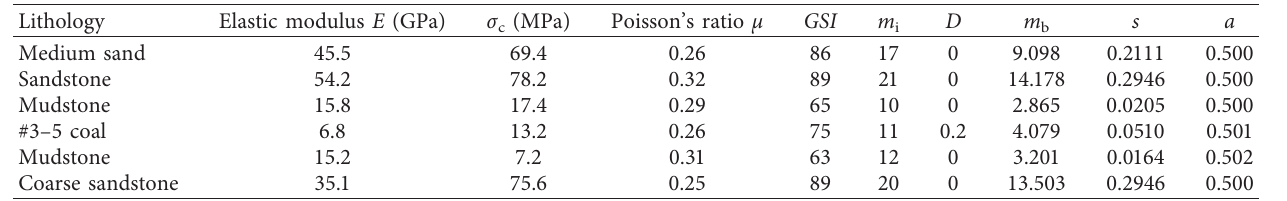
Table 4: Mechanical parameters of the rock.